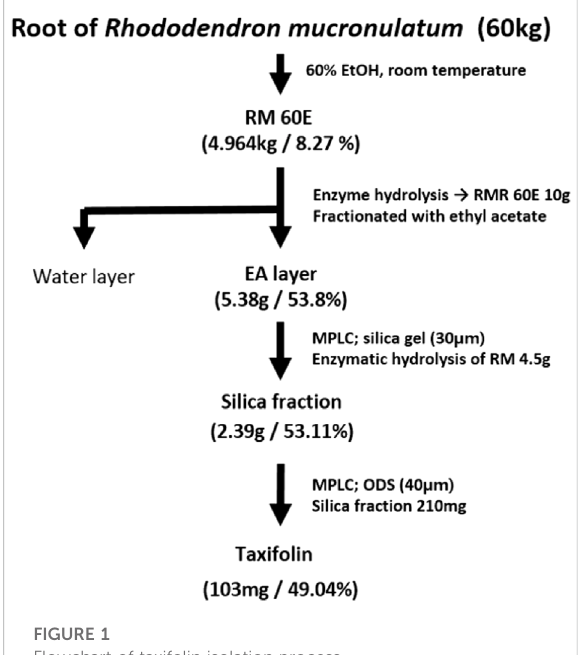
Flowchart of taxifolin isolation